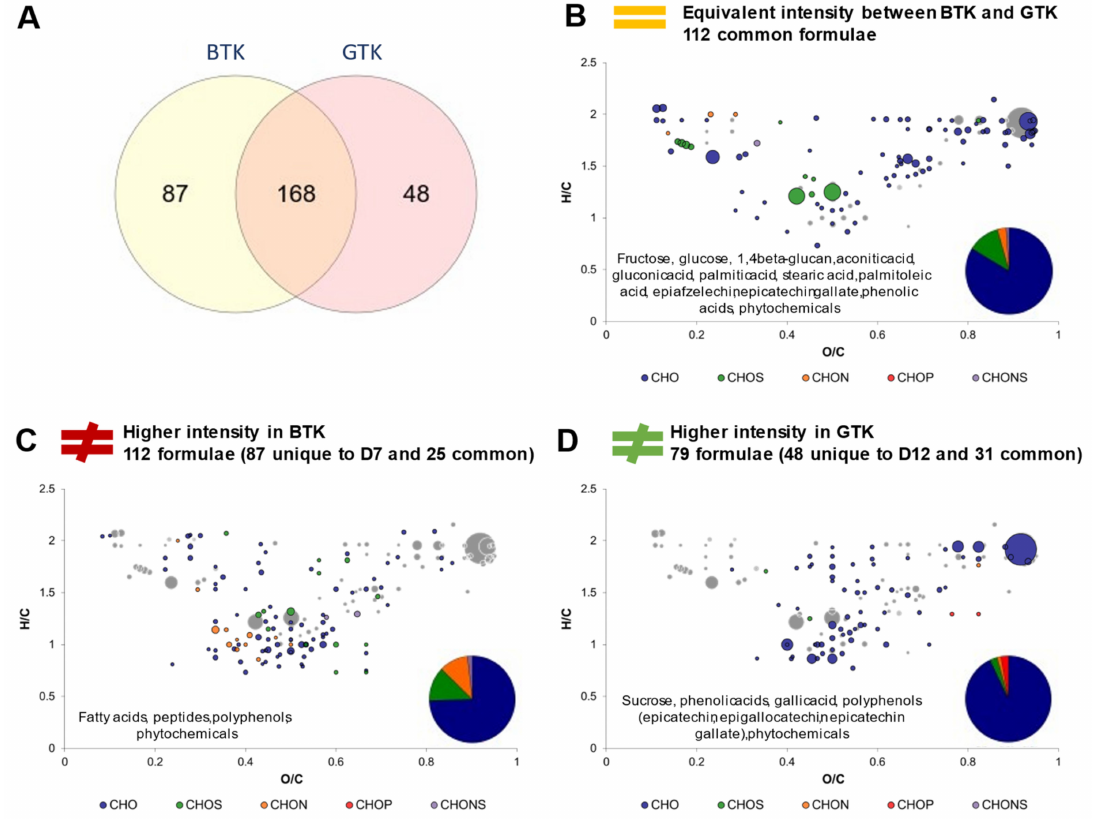
Figure 6. Comparison of composition between black tea kombucha (BTK) and green tea kombucha (GTK) (common formulae between day 7 and day 12). ( A ) Venn diagram of formulae identified in BTK and GTK. Van Krevelen diagrams and putative identities of formula ( B ) equivalent in intensity in both conditions, ( C ) higher in BTK and ( D ) higher in GTK. The surface of bubbles expresses relative formulae intensity. Core metabolites formulae (Figure 2B) are represented in the background in